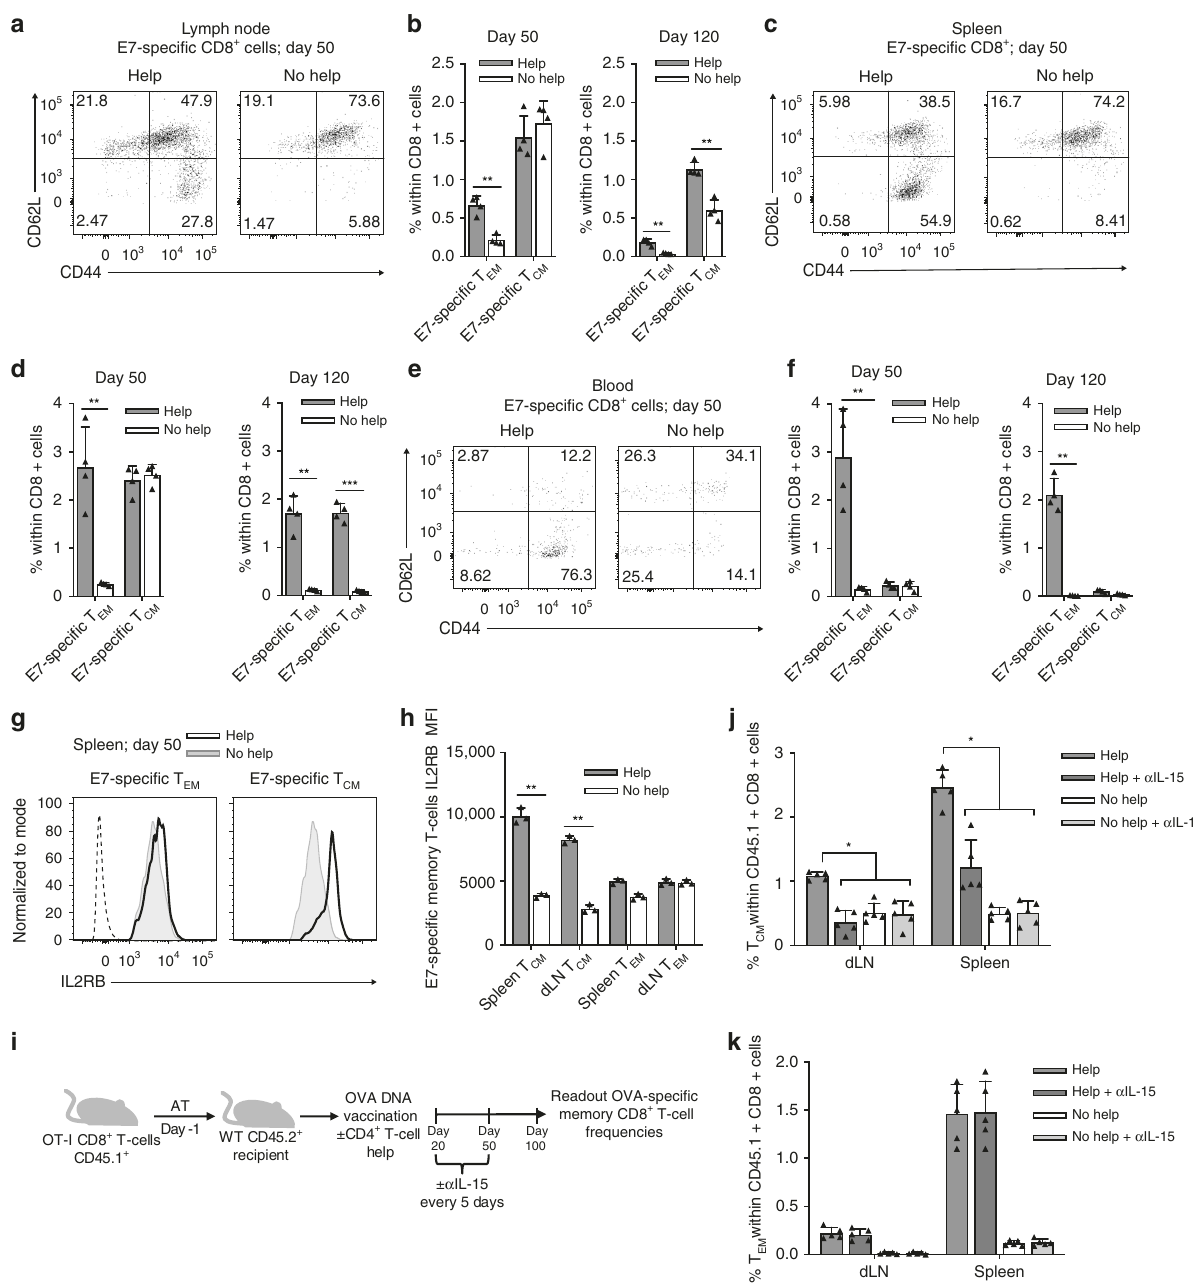
Fig. 2 CD4 + T cell help supports formation of CD8 + T CM and T EM cells. a – f Mice ( n = 4 per group) received Help or No Help vaccine on days 0, 3, and 6 and were analyzed on day 50 or 120. a , c , e Representative fl ow cytometric plots indicating within the H-2D b /E7 49-57 tetramer + CD8 + population frequencies of cells with an effector memory T (T EM ) phenotype (CD44 + CD62L − ) or central memory T (T CM ) phenotype (CD44 + CD62L + ), as determined in draining lymph node (dLN) ( a ), spleen ( c ), and blood ( e ). b , d , f Quanti fi cation of frequencies of E7-speci fi c CD44 + CD62 - T EM and CD44 + CD62 + T CM phenotype CD8 + T cells determined in dLN ( b ), spleen ( d ), and blood ( f ). g , h Cell surface expression of IL2RB (CD122) as determined by fl ow cytometry on E7-speci fi c CD8 + T CM and T EM cell subsets in spleen at day 50. g Primary data. Filled grey: No Help; open black line: Help. Dotted line: unstained control. h Quanti fi cation of mean fl uorescence intensity (MFI) for n = 3. i Experimental set up. CD45.1 + OT-I T cells were adoptively transferred into CD45.2 + recipient mice ( n = 5 per group) that 1 day later received OVA-encoding Help or No Help vaccine. From day 20 onwards, indicated groups were treated with isotype control antibody or neutralizing α IL-15 antibody every 5 days until day 50. j , k Frequencies of CD45.1 + T CM cells ( j ) and T EM cells ( k ) were determined at day 100 in dLN and spleen. Data in this fi gure are from one experiment representative of two experiments. Error bars indicate SD, * p < 0.05, ** p < 0.01, *** p < 0.001 (unpaired two-tailed Student ’ s t test). Source data are provided as a Source Data fi